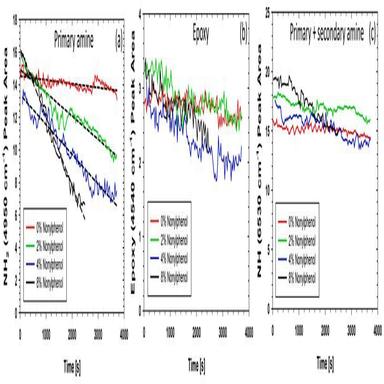
Time evolution of the primary amine (a), epoxy (b) and primary + secondary amine (c) peak areas during cure of Epon 828 and MXD with varying amounts of nonylphenol. Data obtained during DIW print using an in-line spectrometer at room temperature. Dashed lines in (a) represent linear fits to the data.